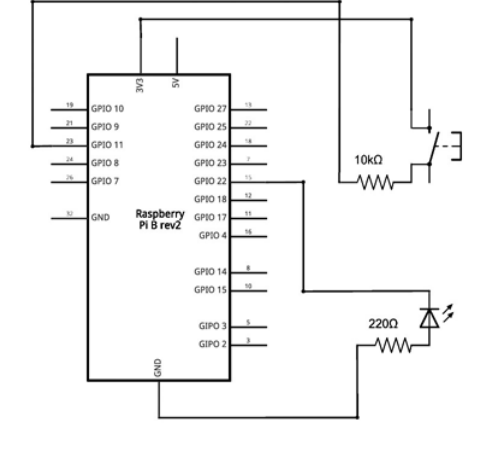
Figure 11: Schematic diagram for reading push